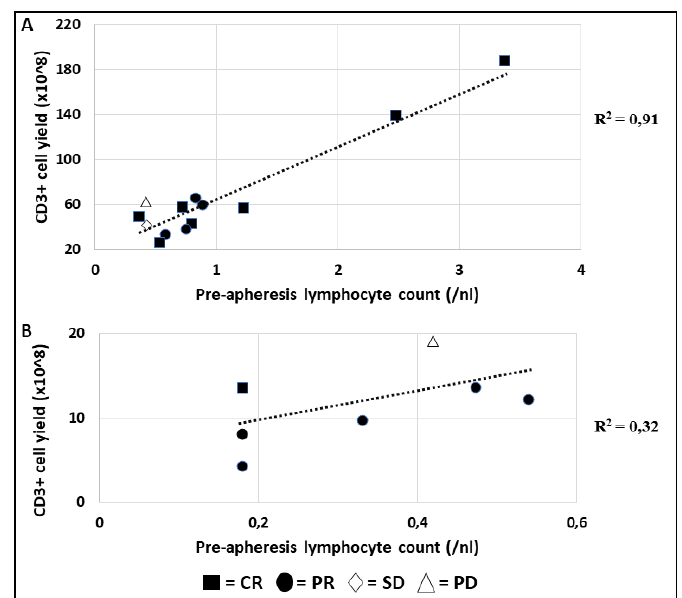
Figure 5. Overview pre-leukapheresis lymphocyte count and CD3+ cell yield by response (axicabtagen ciloleucel). In this figure, pre-apheresis data on lymphocyte count and CD3+ cell yield by response are shown. Group ( A ) displays a CD3+ cell yield of >20 (×10 8 ), (( B ) group ≤ 20 (×10 8 )). Splitting of this figure in two panel groups was done for improved graphic display.